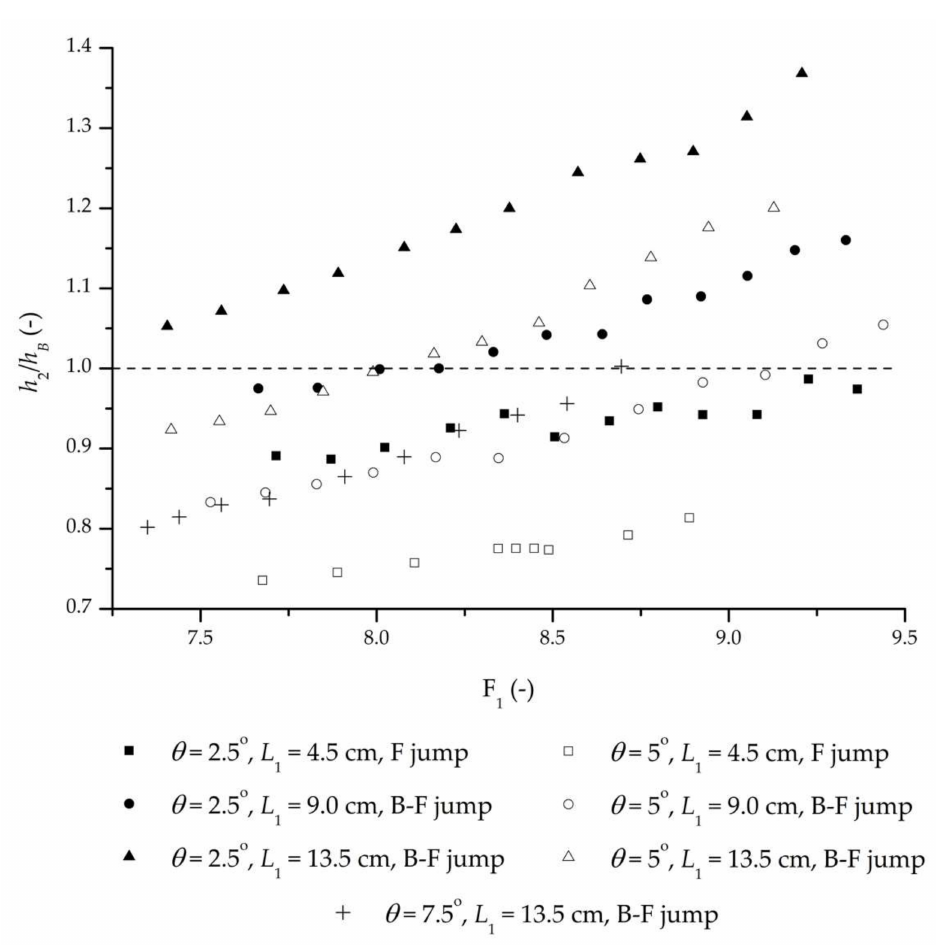
Figure 13. Comparison of h 2 / h B for different configurations of F and B-F